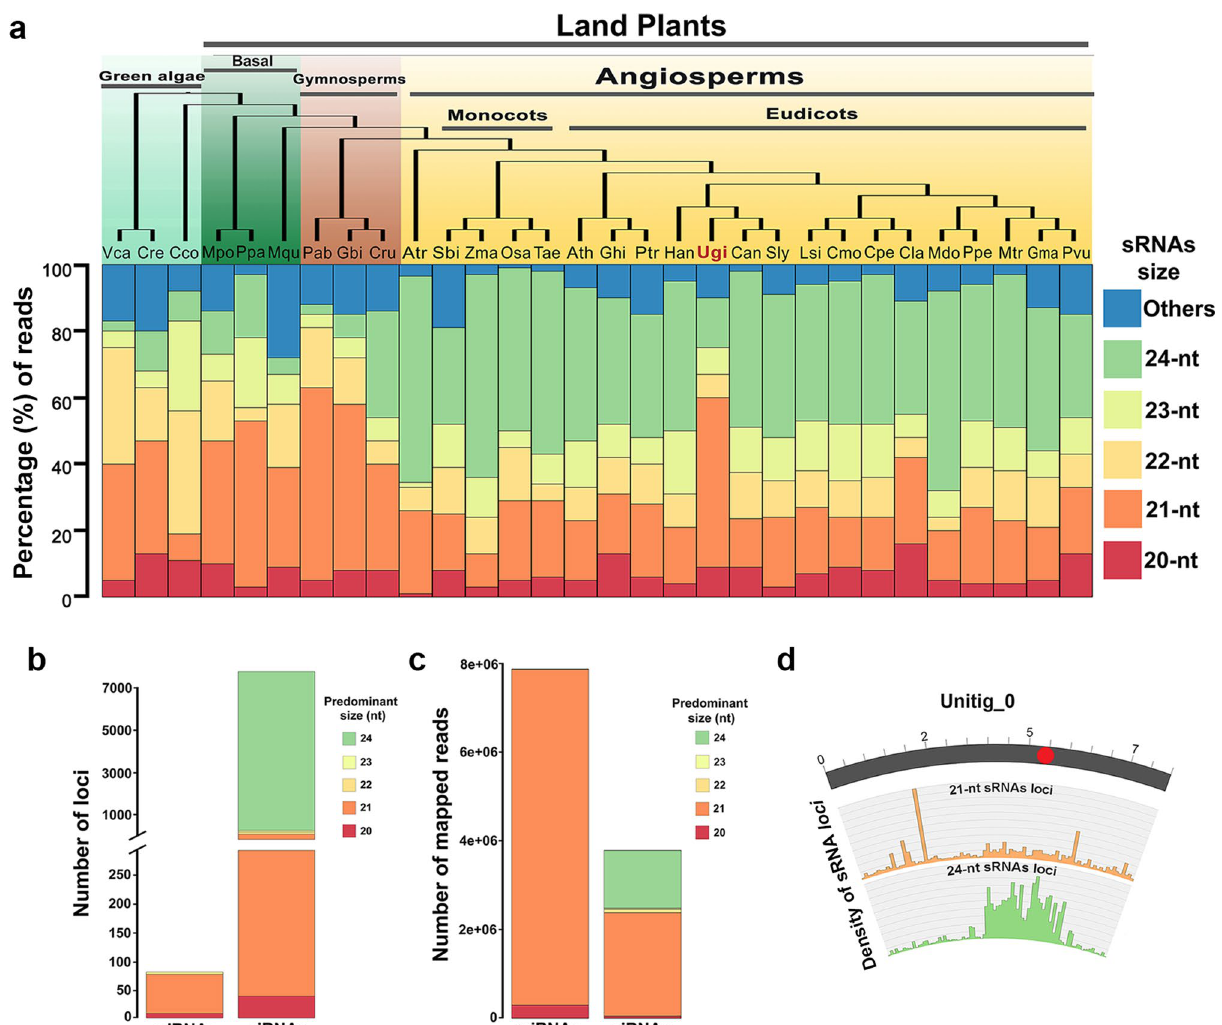
Figure 3. Annotation of sRNAs in U. gibba and distribution of small RNA size abundance in plants. ( a ) Top, a phylogenetic tree of plants with representative species for green algae, early branching land plants, gymnosperms, and angiosperms. Bottom, a stacked plot of small RNA abundances (20-nt to 24-nt in size) from various small RNA-seq studies. Y-axis shown the percentage of reads for each size group. ( b ) Total locus predictions from ShortStack for miRNAs and siRNAs at different sizes. ( c ) Numbers of reads mapped per loci at different sizes from ShortStack. ( d ) The largest complete chromosome (Unitig_0) representation of gene density, TE density, 21-nt small RNAs loci density distribution and 24-nt small RNAs loci distribution. Vca: Volvox carteri; Cre: Chlamydomonas reinhardtii; Cco: Chara coraline; Mpo: Marchantia polymorpha; Ppa: Physcomitrella patens; Mqu: Marsilea quadrifolia; Pab: Picea abies; Ginkgo biloba; Cru: Cycas rumphii; Atr: Amborella trichopoda; Sbi: Sorghum bicolor; Zma: Zea mays; Osa: Oryza sativa; Tae: Triticum aestivum; Ath: Arabidopsis thaliana; Ghi: Gossypium hirsutum; Ptr: Populus trichocarpa; Han: Helianthus annuus; Ugi: Utricularia gibba; Can: Capsicum annuum; Sly: Solanum lycopersicum; Lsi: Lagnaria siceraria; Cmo: Cucurbita moschata; Cpe: Cucurbita pepo; Cla: Citrullus lanatus; Mdo: Malus domestica; Ppe: Prunus persica; Mtr: Medicago truncatula; Gma: Glycine max; Pvu: Phaseolus vulgaris